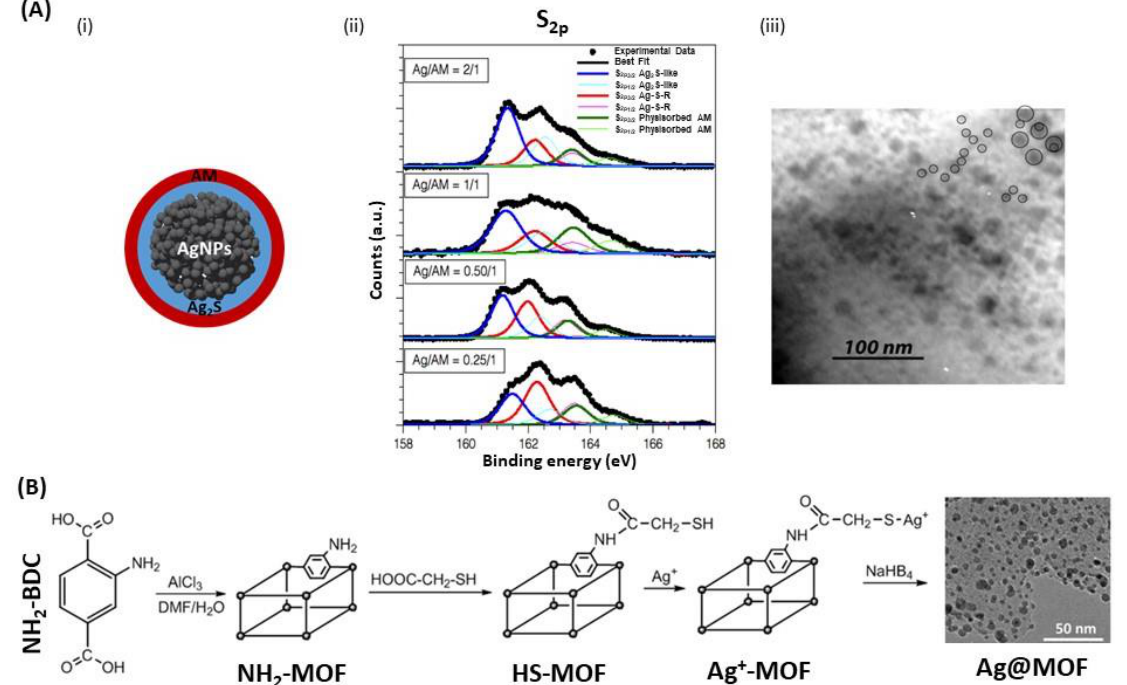
Figure 10. ( A ) Allylmercaptane-stabilized AgNPs: (i) core@shell morphology for allylmercaptane- (AM)-functionalized AgNPs through Ag-S chemical bonds to form the external layer, (ii) XPS spectra of Ag@AM with four different Ag/thiol ratios, and (iii) TEM images of AgNPs with Ag/AM molar ratio equal to 2/1 (AgNPs dimensions are 9 ± 3 nm and a population of NPs aggregated of 18 ± 6 nm. ( B ) Illustration of the encapsulation of AgNPs in thiol-modified metal-organic framework (MOF) as a host matrix. Adapted from [119,120]. Copyright (2012), American Chemical Society. Copyright (2015), Royal Society of Chemistry.